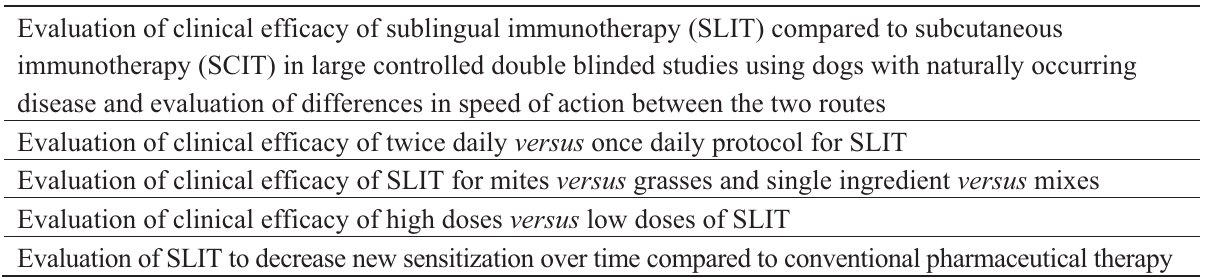
Table 1. Unmet needs in canine atopic dermatitis